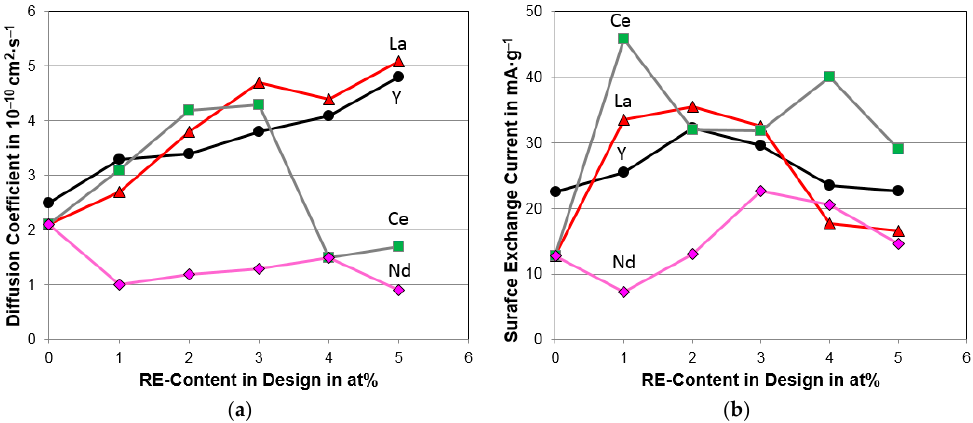
Figure 13. Evolutions of ( a ) bulk diffusion coefficient and ( b ) surface exchange current with increasing RE-content in the design.